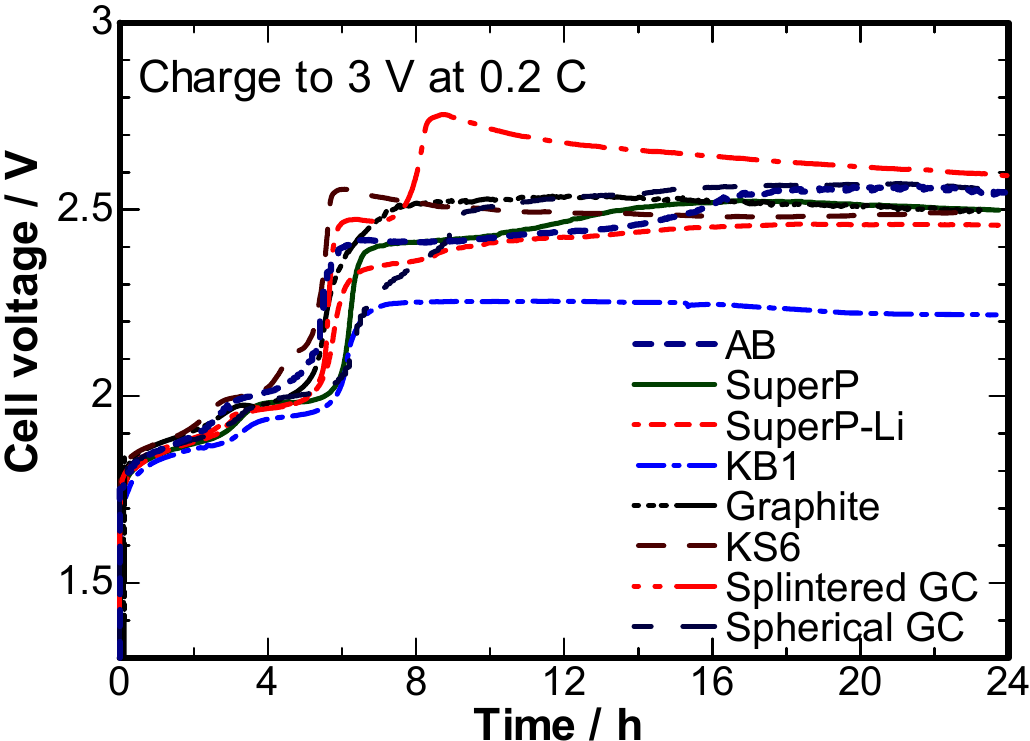
Figure 4. Charge profiles of di ff erent types of carbon. Batteries 2020 , 6 , x FOR PEER REVIEW